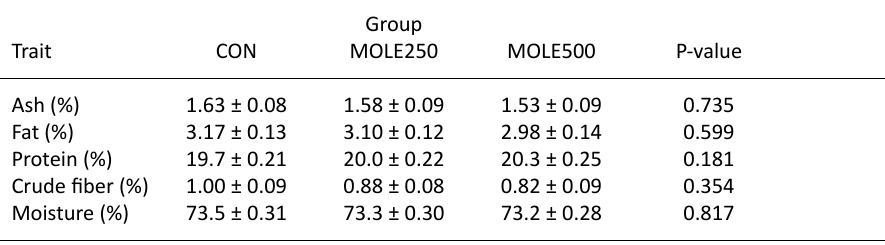
Table 2. Effect of Moringa oleifera leaf extract (MOLE) on breast muscle composition